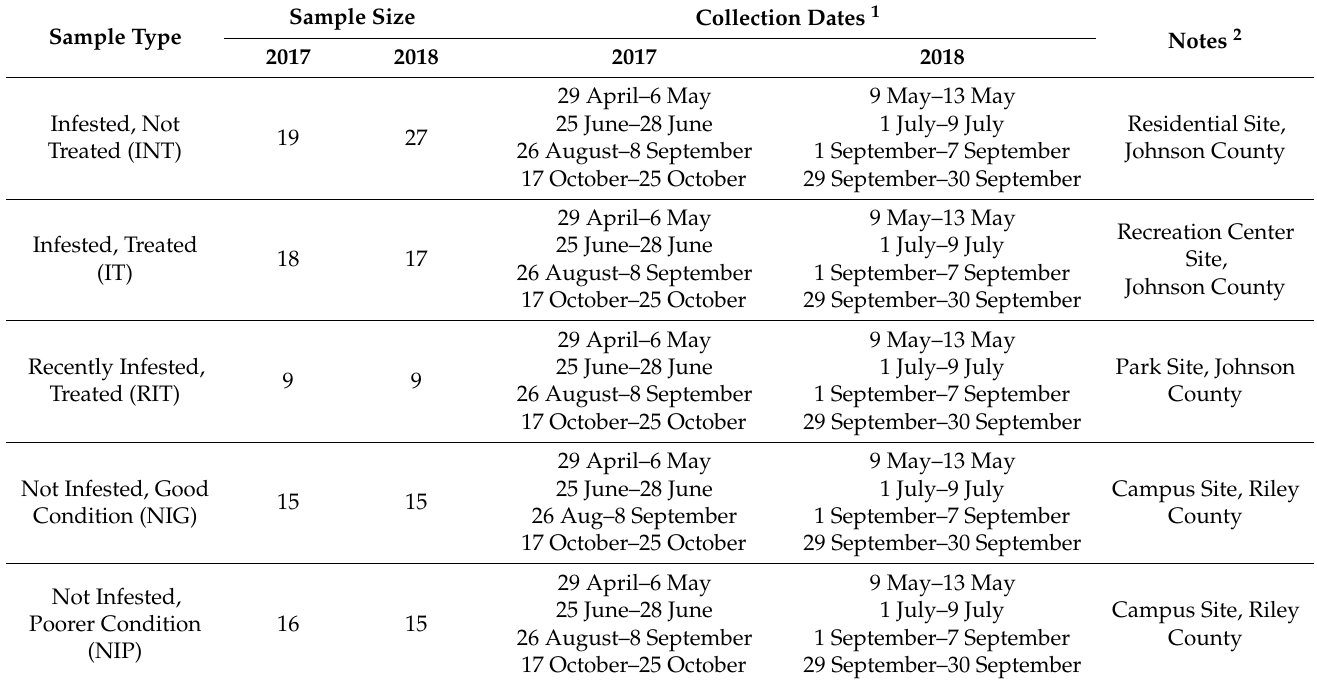
Table 2. Summary of Sample